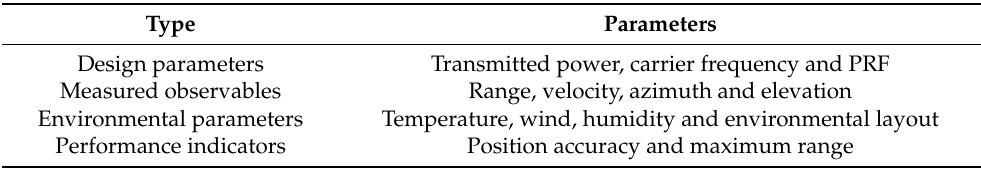
Table 2. Acoustic sensor ranging